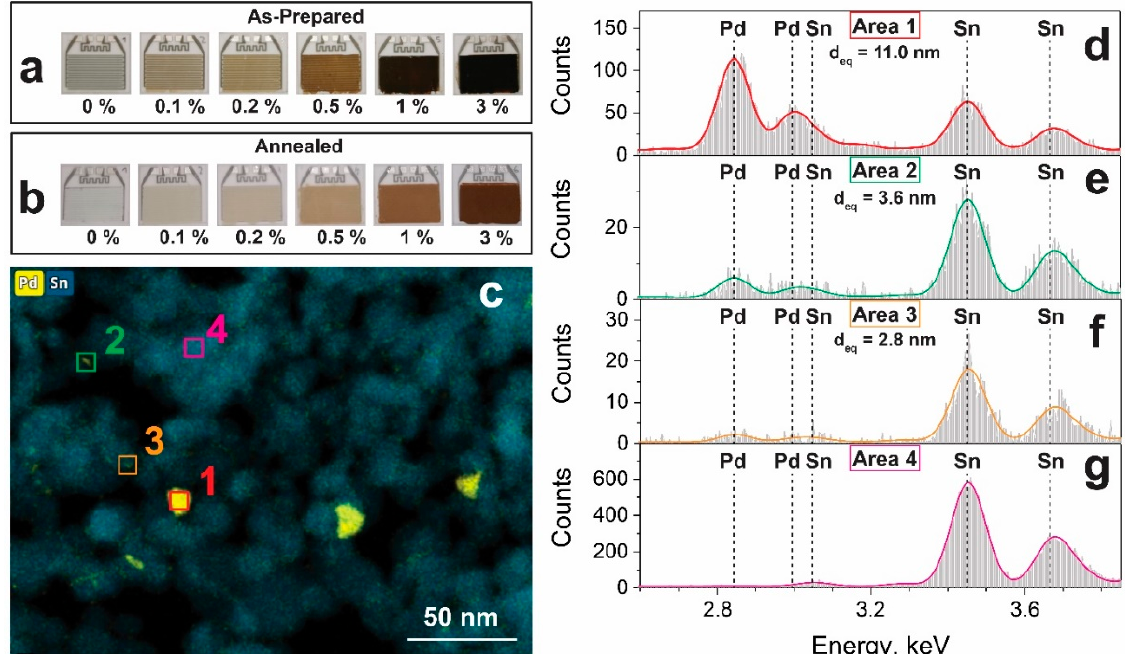
Figure 2. Sensor substrates covered with ( a ) as-prepared and ( b ) annealed films of Pd-loaded SnO 2 . ( c ) Overlayed elemental maps of Pd (yellow) and Sn (blue) of annealed 3 mol% Pd-loaded SnO 2 . The EDX spectra of selected areas are depicted in the right panel: a large Pd-containing cluster (Area 1), spectrum in ( d ), a medium-sized (Area 2), spectrum in ( e ) and a small one (Area 3), spectrum in ( f ) as well as a Pd-free SnO 2 region (Area 4), spectrum in ( g ). Colored lines represent the fitted EDX peaks.